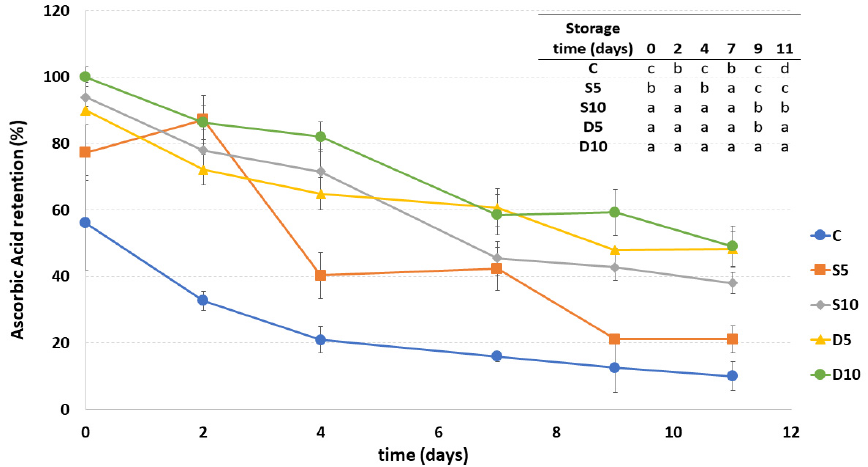
Figure 6. Ascorbic acid retention (%) of fresh-cut melon samples (C, D5, D10, S5 and S10) during storage. a–d Different letters in the same column indicate significant differences ( p < 0.05) between all considered samples at each storage time.